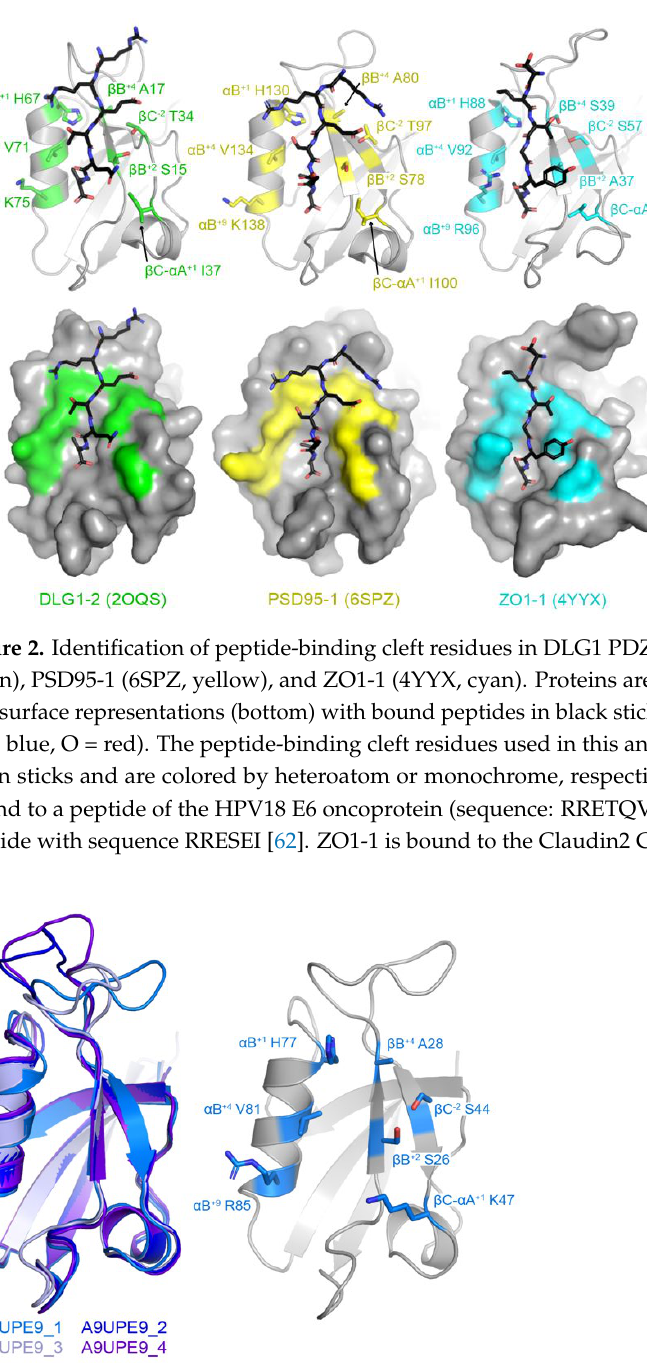
Figure 3. Model of A9UPE9 PDZ structure. The four conformations from Robetta are in cartoon representation and colored as labeled in ( a ). ( b ) Identification of peptide-binding cleft residues in